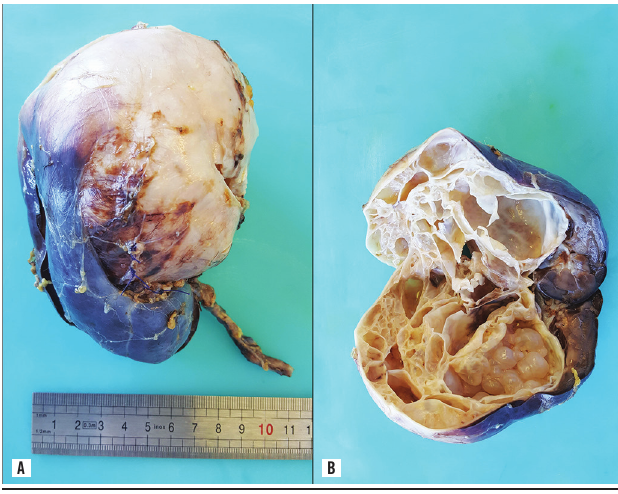
figurE 2 − Gross examination: right nephrectomy showing, on cut section, a multicystic lesion with 10 × 8 × 6.5 cm, located in the middle and upper portion of the kidney, with smooth inner surface and thin cyst wall